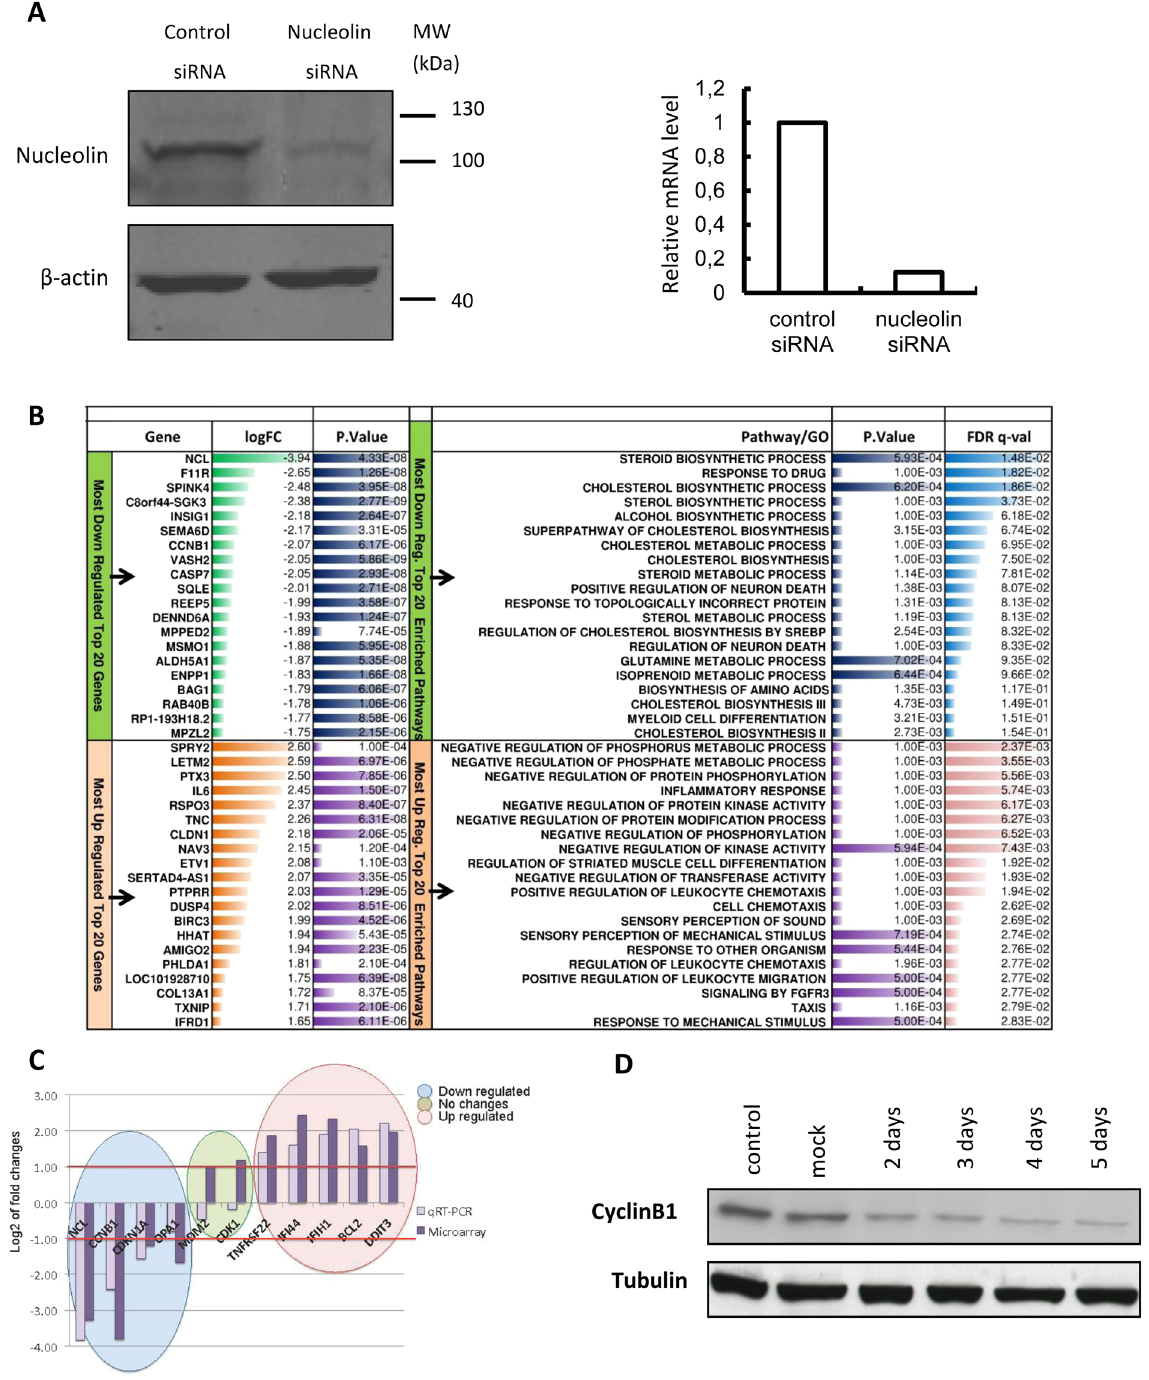
Figure 2. Transcriptomic analysis of nucleolin depleted cells. ( A ) HeLa cells were treated with control or NCL siRNA as previously described 27, 28 and after 5 days, protein extracts and total RNA were prepared. NCL protein expression was assessed by western blot and normalized by comparison with β -actin (left panel) while NCL mRNA level was measured by RT-qPCR (right panel). ( B ) Lists of the 20 most down or up- regulated genes and their fold change (FC) and p-values with top 20 pathways and GOBP terms enriched with least FDR-q value. ( C ) RT-qPCR validation of genes that were found either up-, down- or unchanged in the microarray analysis. NCL was included in the analysis, together with some genes involved in cell cycle regulation and other randomly chosen genes. ( D ) Western blot analysis with total extract of the expression of CCNB1 protein upon the depletion of NCL. As CCNB1 was strongly down-regulated and may be important for the arrest of HeLa cells in G2/M phase upon NCL depletion, we choose this protein to check for the correspondence between RNA level (Affymetrix microarrays-RT-qPCR) and protein